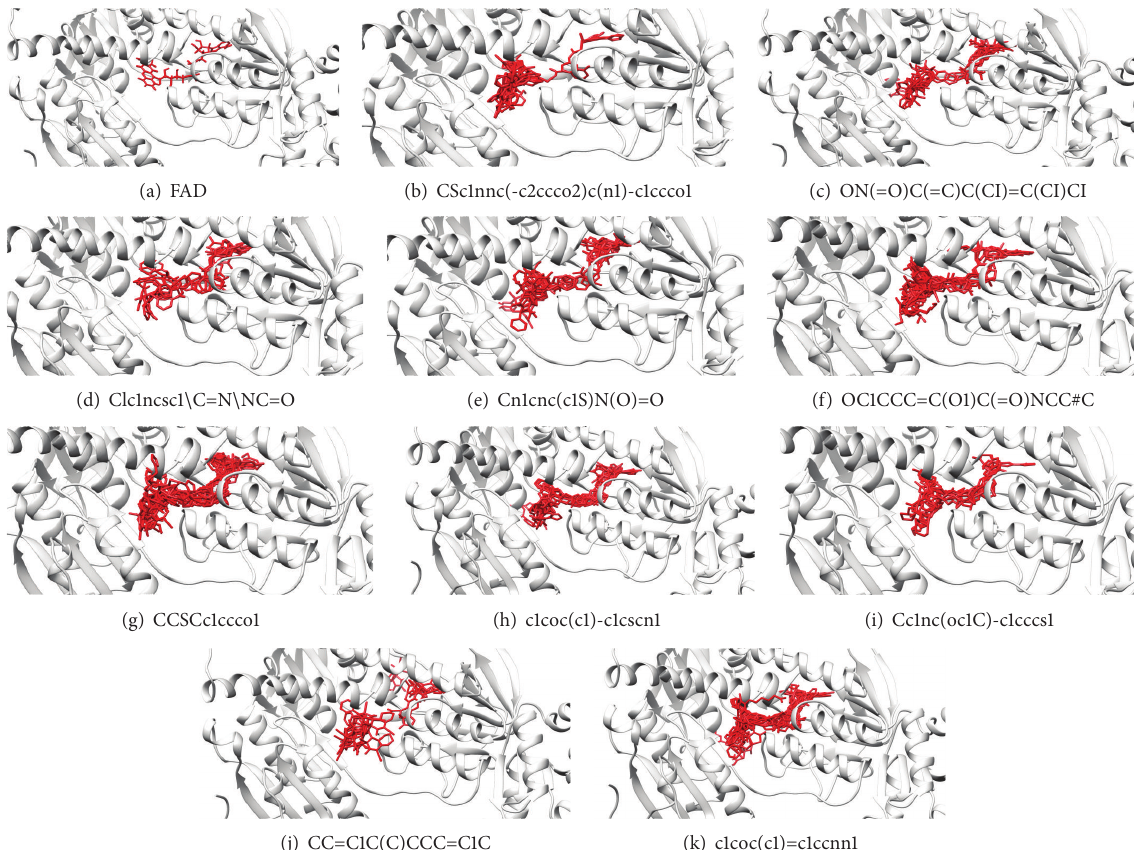
Figure 3: Docked molecules. (a) FAD and all the actives (b)–(k) corresponding to 10 enriched scaffolds in the enzyme TGR.